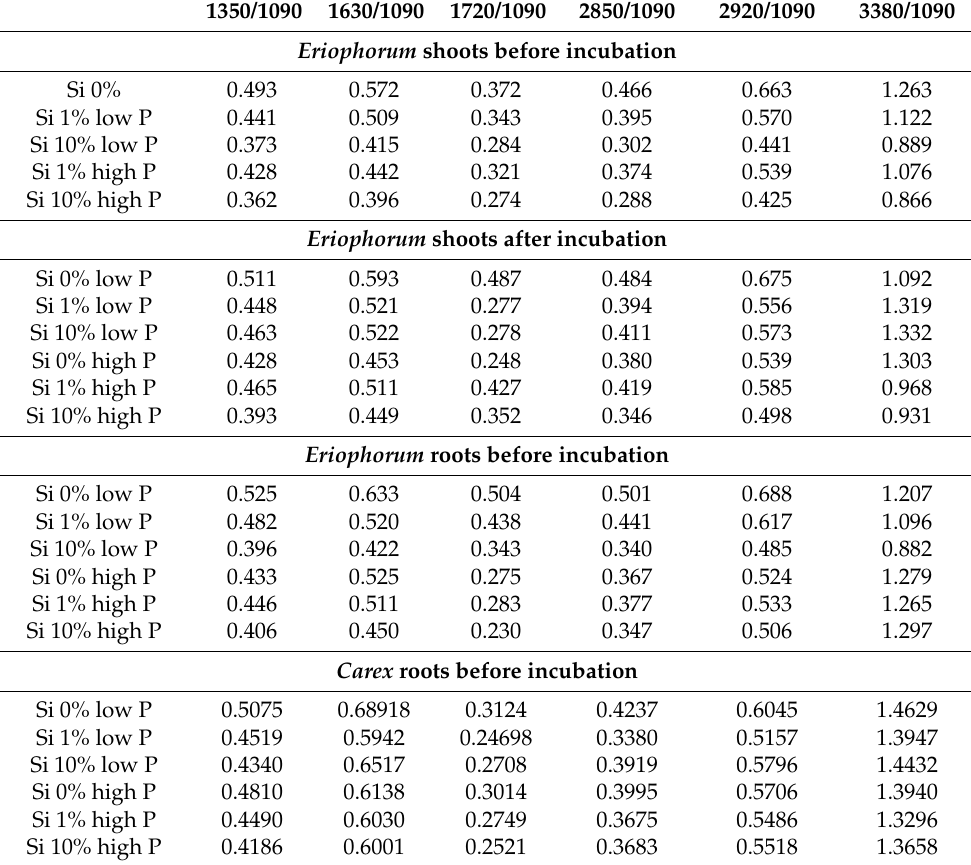
Table A3. Selected FTIR ratios of plants before and after incubation.